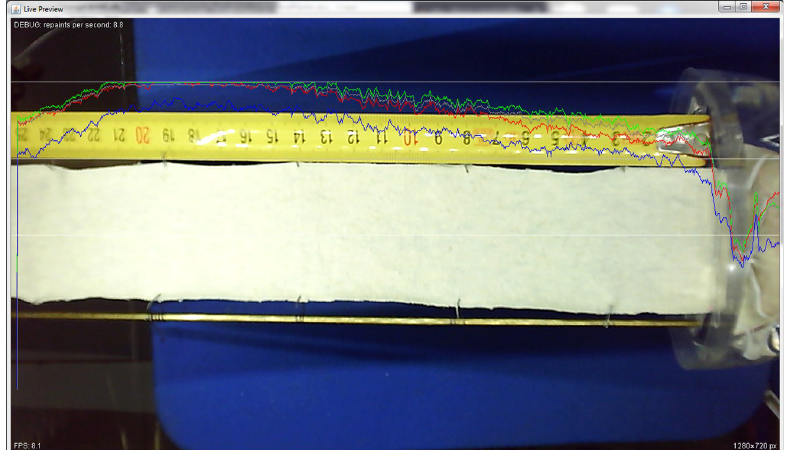
Fig 5. Live preview—example of wrong setting of